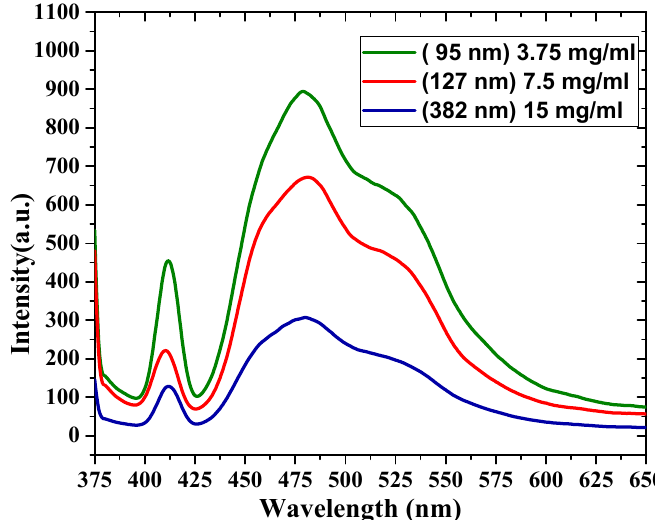
Figure 7. Photoluminescence (PL) spectra for different film thicknesses (380, 127 and 90 nm). Table 2. The photoluminescence (PL) ratio of the different peaks of the CO films. PL intensity (a.u) Samples (Concentration/Thickness)